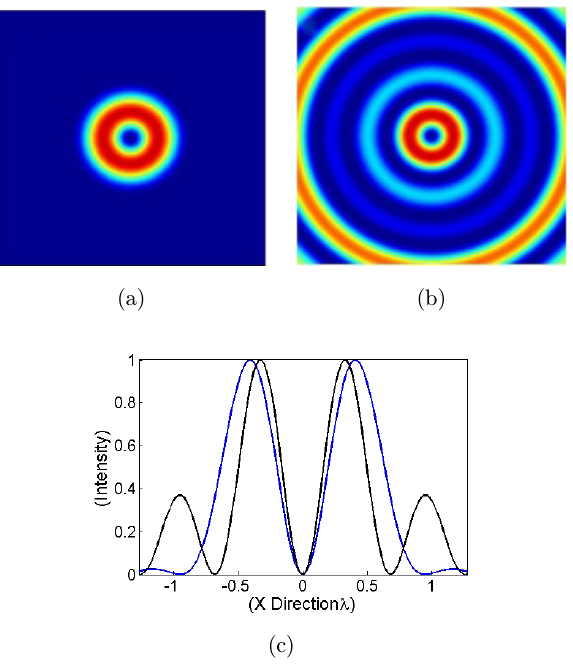
Fig. 1. (Color online) (a) Intensity distribution in focus without the binary optics. (b) Intensity distribution in focus with the binary optics. (c) Cross-section of intensity distribu- tion with (black line) and without (blue line) the binary